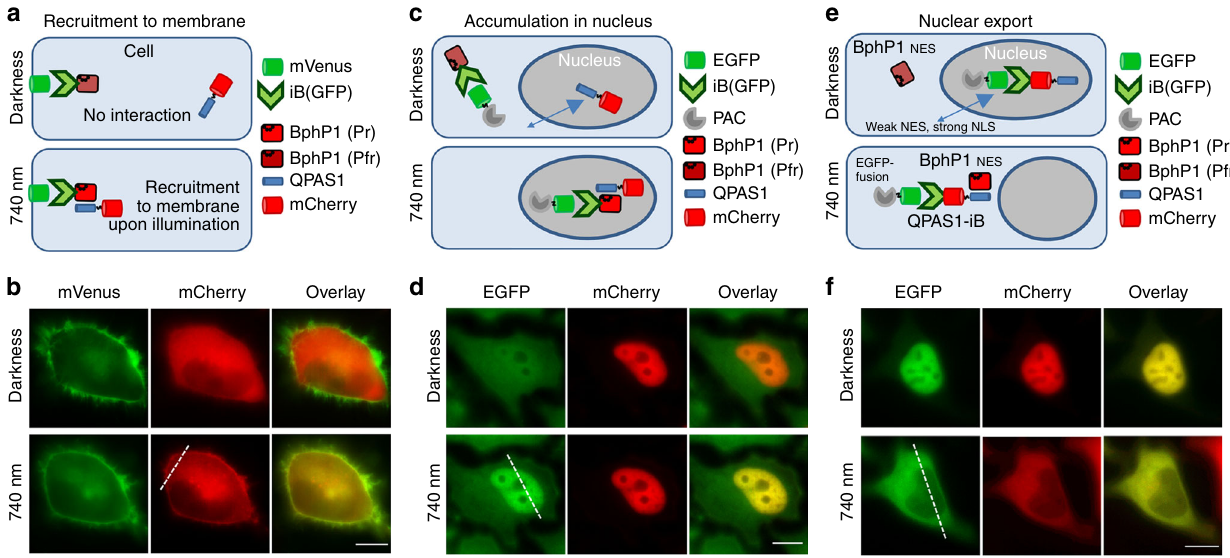
Fig. 1 Engineering intrabodies to enable their optogenetic control. a Schematic representation of light-induced recruitment of QPAS1-mCherry to the target protein bound to membrane, where interaction with membrane-bound mVenus occurs via intrabody (iB) fused to BphP1. b Relocalization of QPAS1- mCherry to plasma membrane under 740 nm illumination. Epi fl uorescence microscopy; scale bar, 10 µ m. c Schematic representation of genomically expressed EGFP-PAC relocalization from cytoplasm to the cell nucleus upon illumination. d EGFP-PAC relocalization in cells expressing BphP1-iB(GFP) and NES-mCherry-QPAS1-NLS. In darkness, the QPAS1 fusion is shuttling between nucleus and cytoplasm, driven by strong NLS and weak NES. Upon 740 nm illumination, it interacts with BphP1 and recruits EGFP-PAC into the nucleus. Epi fl uorescence microscopy; scale bar, 10 µ m. e Schematic representation of nucleus-to-cytoplasm relocalization of genomically expressed GFP-fusion using NIR light-controlled intrabody. f Cells expressing genomically EGFP-PAC and transiently BphP1-NES and iB(GFP)-NES-mCherry-QPAS1-NLS. Under 740 nm illumination, EGFP-PAC accumulates in the cytoplasm. Epi fl uorescence microscopy; scale bar, 10 μ m. Fluorescence intensity pro fi les corresponding the dashed lines in b , d , and f are shown in Supplementary Fig.